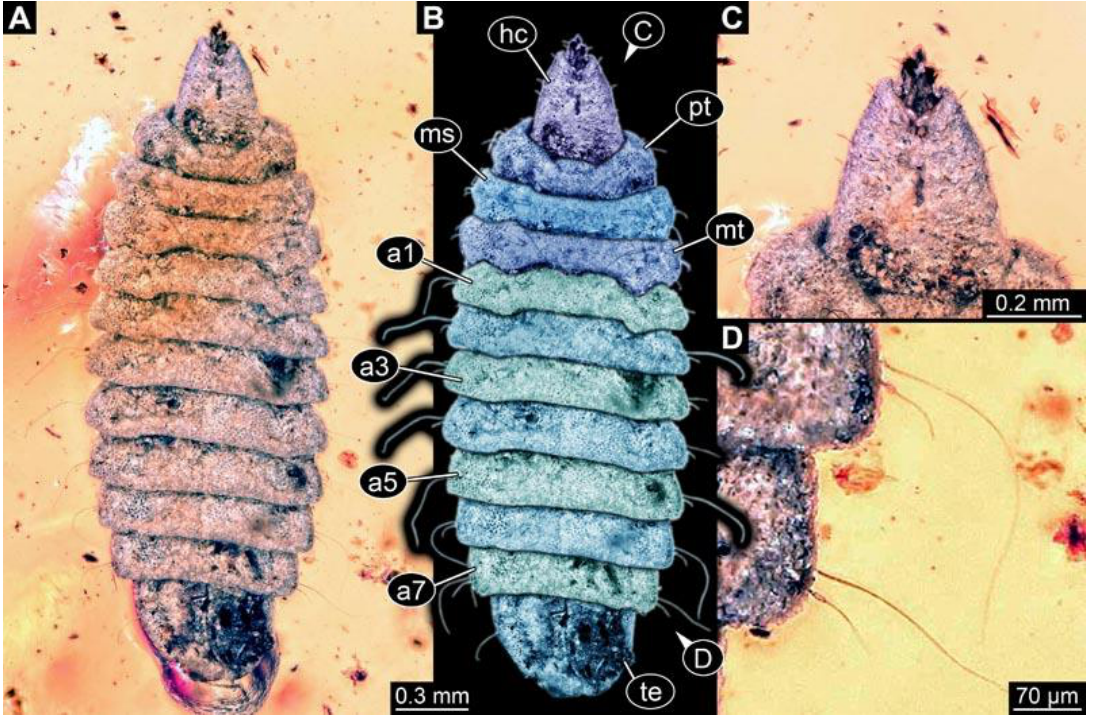
Figure 14. Fossil larva of morphotype 2, specimen PED 0789. ( A ). Dorsal view. ( B ). Colour-marked. ( C ). Close-up of head capsule. ( D ). Close-up of lateral hair-like setae. Abbreviations: a1 – a7 = abdo- men units 1 – 7; hc = head capsule; ms = mesothorax; mt = metathorax; pt = prothorax; te = trunk end. (112) PED 0821: Specimen accessible in dorsal and ventral view, better visible in dor- sal view (Figure 15). Surface structure apparent, bright pigmentation on the whole body.